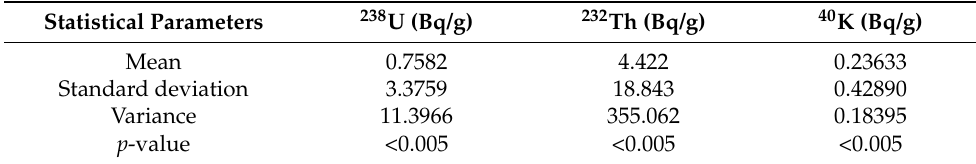
Table 2. Normality test results for data of consumer products containing NORM using the Minitab statistical tool.